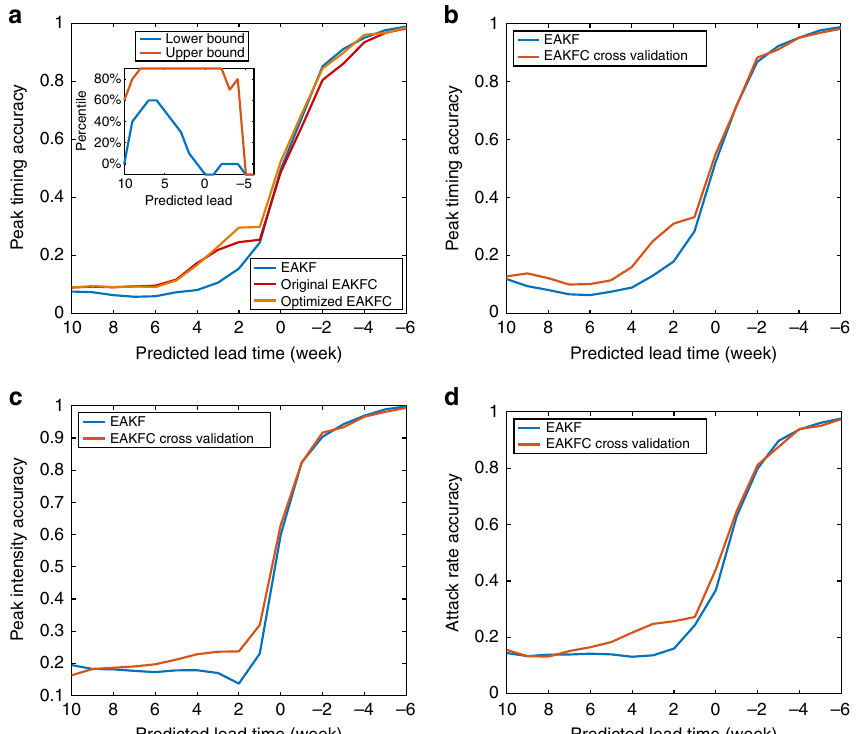
Fig. 5 Optimization of the selective rule for the EAKFC. a We used the simulated annealing algorithm to fi nd the best selective rule that maximizes the improvement of peak timing accuracy using the EAKFC. The optimization is performed on the predictions for 95 cities in the United States from timing for the EAKF, the original EAKFC in which the correction procedure is applied indiscriminately, and the optimized EAKFC that adaptively adopts error correction according to the selective rule. b – d Forecast accuracy of peak timing ( b ), peak intensity ( c ), and attack rate ( d ) of the EAKFC for the 2-fold cross validation. We randomly chose half the historical outbreaks and used these to optimize the selective rule, and then performed retrospective forecasts for the remaining records. Curves are averaged over 100 independent realizations of this cross retrospective forecasts of EAKF and adaptive EAKFC constrained by θ . At each iteration, a new con fi guration θ ′ is generated by imposing a +10 or − 10% perturbation on a randomly selected element θ lower ( t lead ) or θ upper ( t lead ) of the original con fi guration θ . Whether the new con fi guration θ ′ is accepted depends on the acceptance probability function: